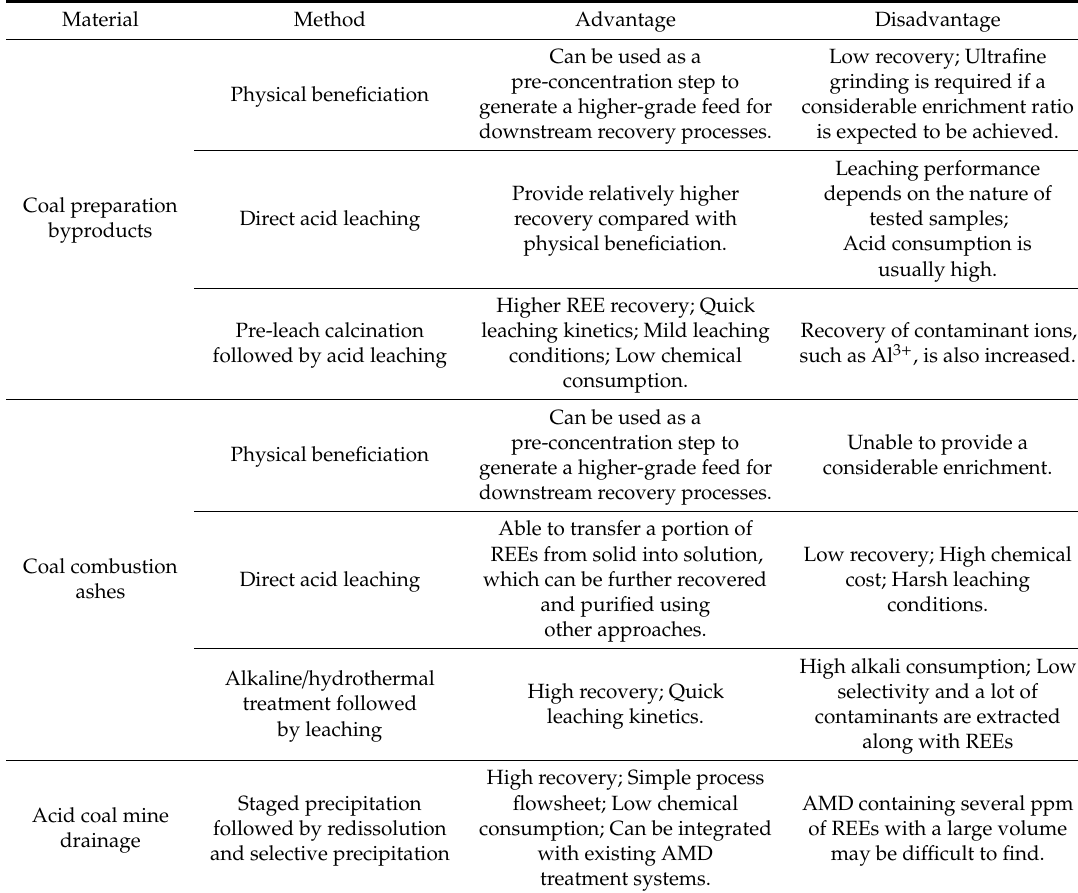
Table 5. A summary of the advantages and disadvantages of the methods that have been used for REE recovery from coal-related